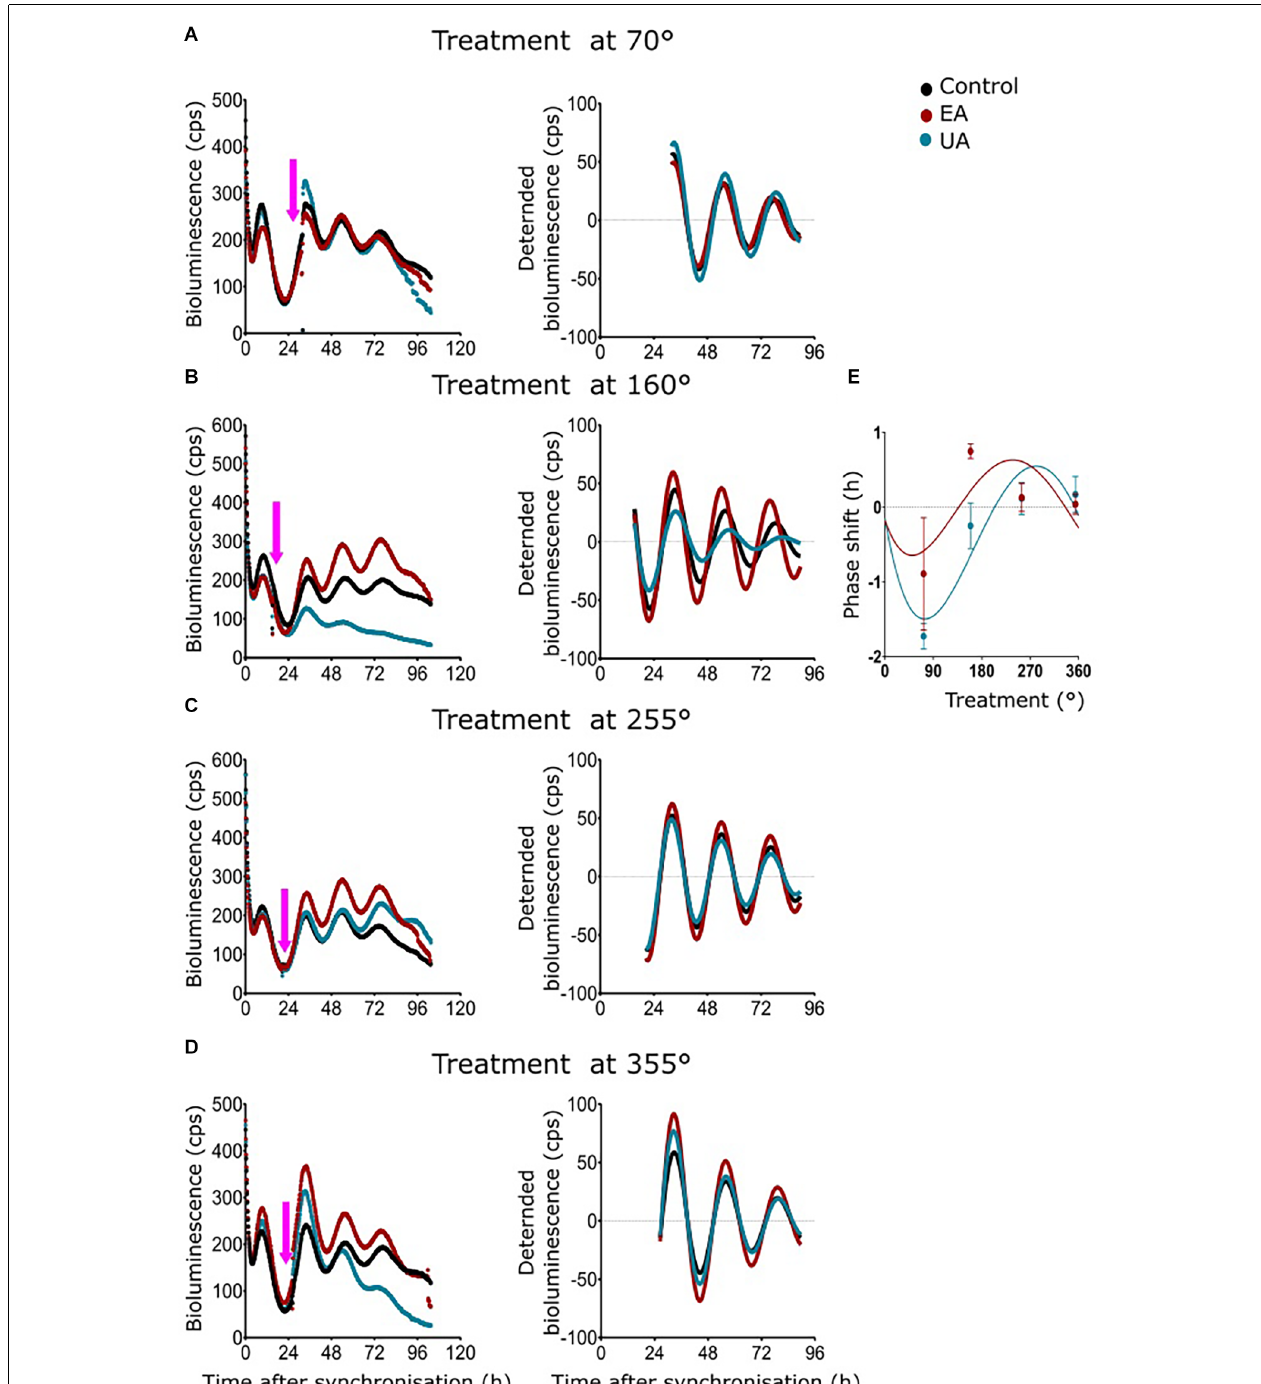
FIGURE 5 | Phase response curves (PRCs) of MEF Per2:luc rhythms after timed treatment with secondary lichen metabolites. (A–D) Raw bioluminescence data (left) and normalized curve fits (right) of luminescence in MEF-P2L cells treated with 10 µ g/ml of UA (blue) or EA (red) vs. solvent control (PBS/DMSO; black) at 70 ◦ (A) , 160 ◦ (B) , 255 ◦ (C) , or 355 ◦ (D) of the pre-treatment Per2:luc rhythm. Pink arrows depict treatment time points. (E) PRC of the same data set ( n = 3 per time point; data are averages ±